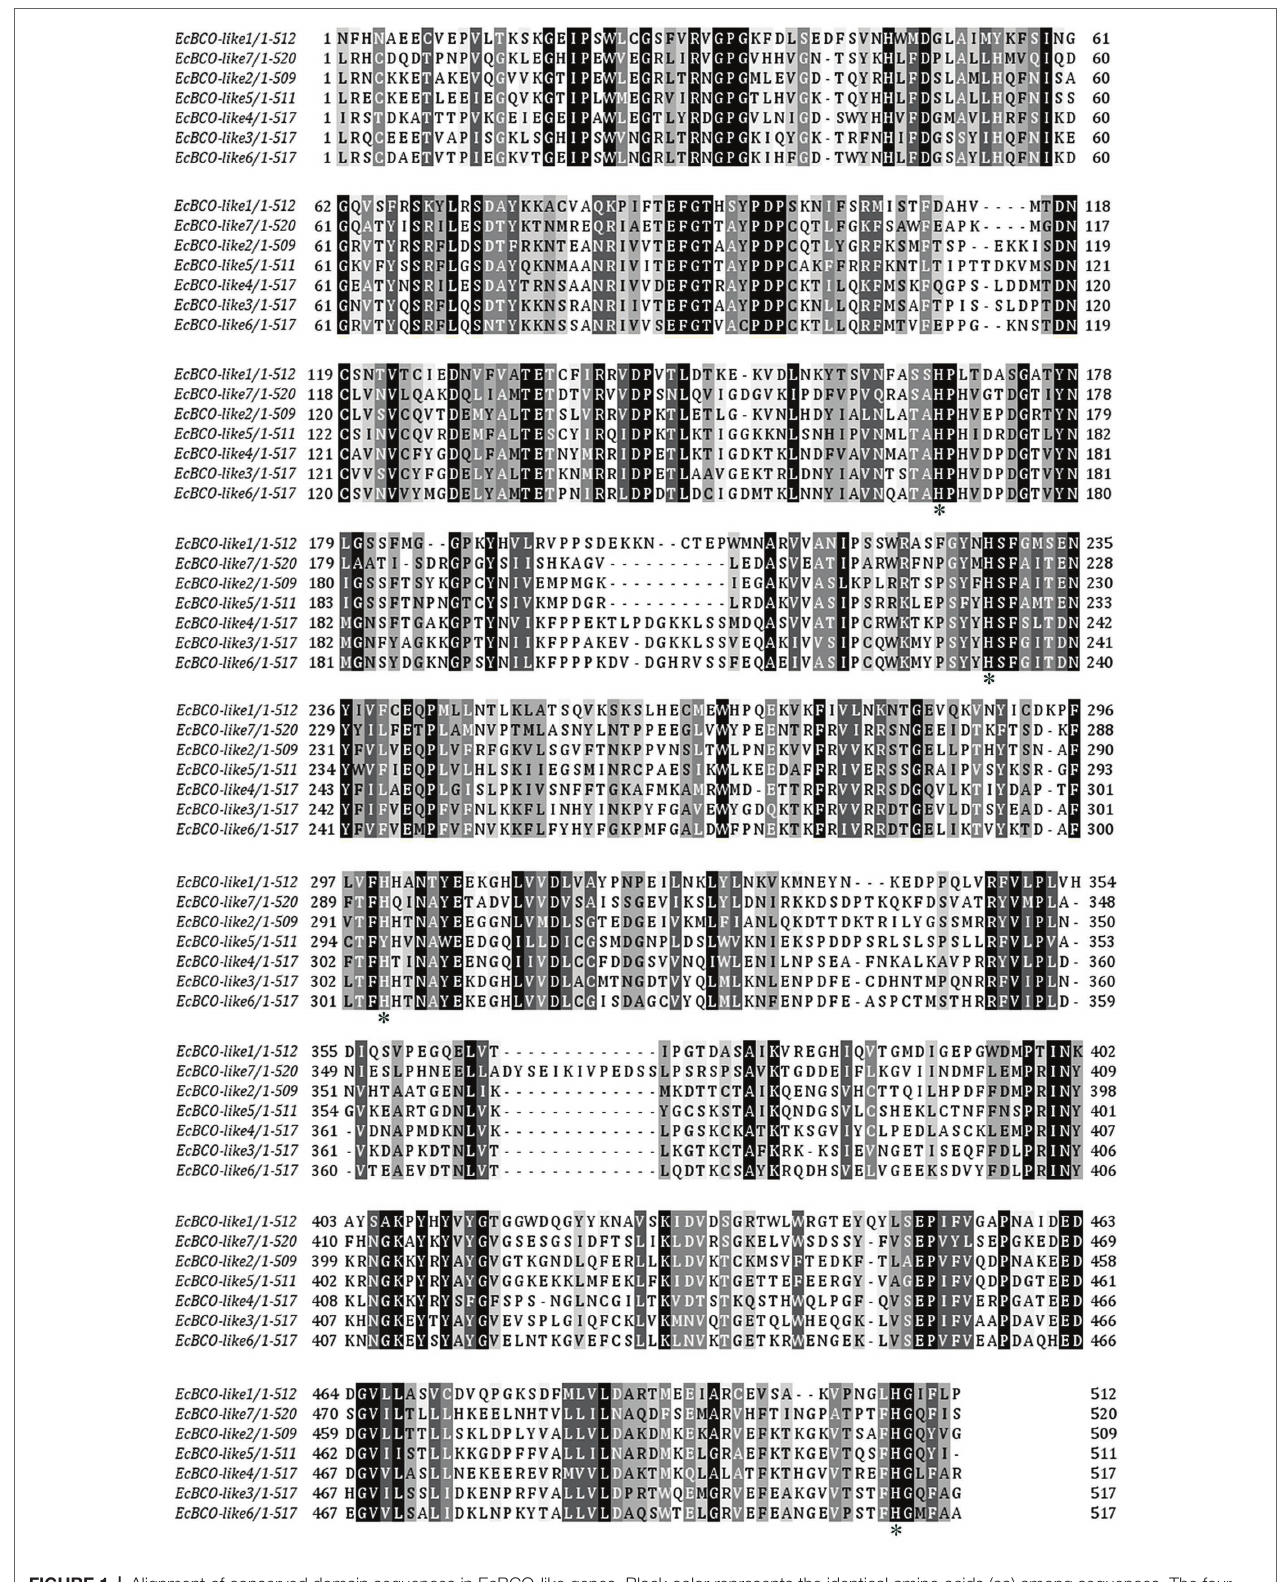
FIGURE 1 | Alignment of conserved domain sequences in EcBCO-like genes. Black color represents the identical amino acids (aa) among sequences. The four conserved histidine residues related to Fe 2+ binding site are marked with asterisks ( *